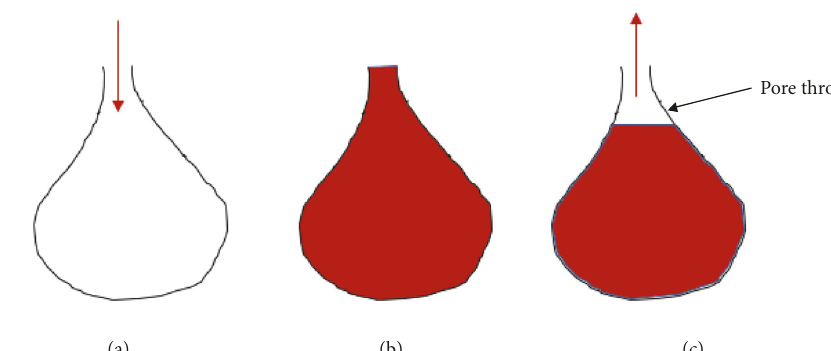
Figure 3: The simplification processes of HPMI test. The pore is simplified to ink bottle shape,the image (a) representsthe empty pore, image (b) is the pore filled with mercury, and image (c) represents that some mercury remains in the pore inside after the extrusion process.